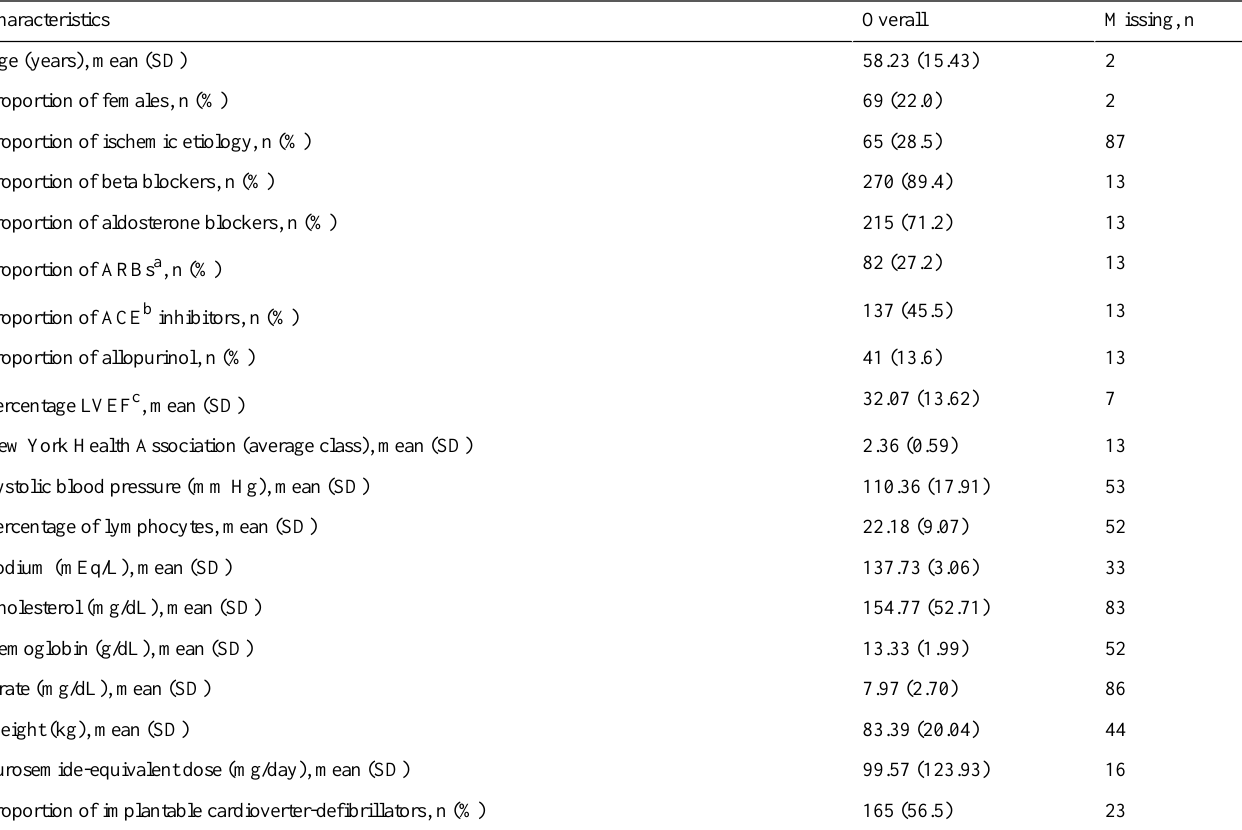
Table 1. Baseline patient characteristics of the Medly Program Evaluation cohort (n=315; number of patients unless specified otherwise).